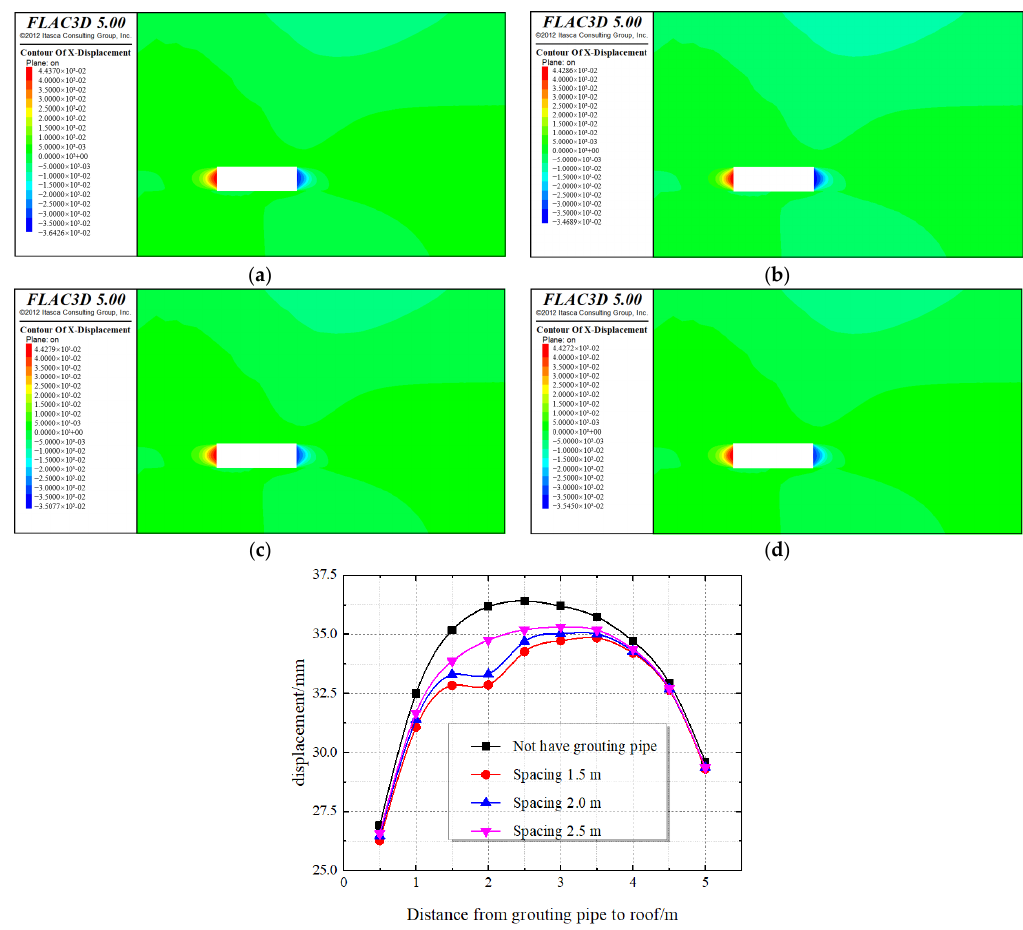
Figure 16. Horizontal displacement diagram of monitoring points with different spacing of grouting pipes: ( a ) no grouting pipe; ( b ) grouting pipe spacing is 1.5 m; ( c ) grouting pipe spacing is 2.0 m; ( d ) grouting pipe spacing is 2.5 m; ( e ) displacement line chart.